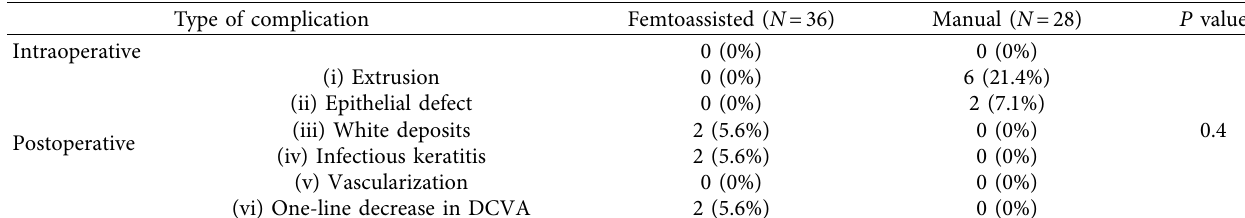
Figure 2: Corneal tomography before (a) and after (b) manual Myoring implantation. Table 3: Adverse events of both